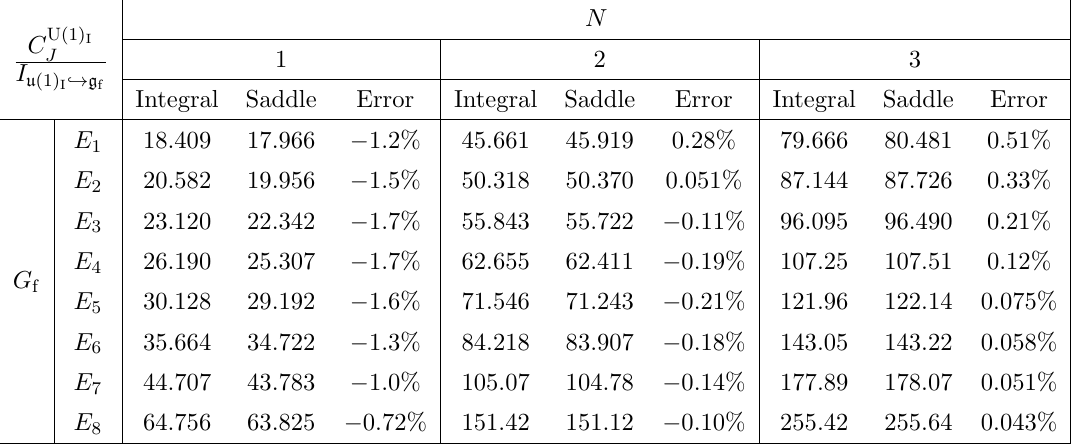
in the rank-one to rank-three J